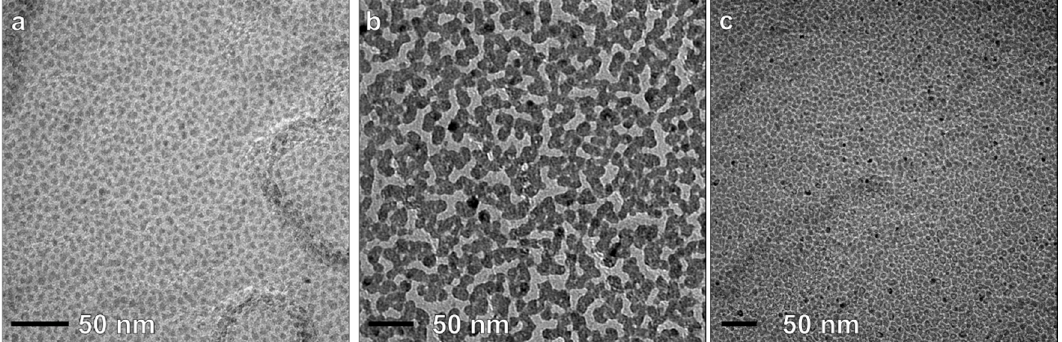
Figure 1. Transmission electron microscopy (TEM) micrographs of ZnO-CF x nanocomposites having